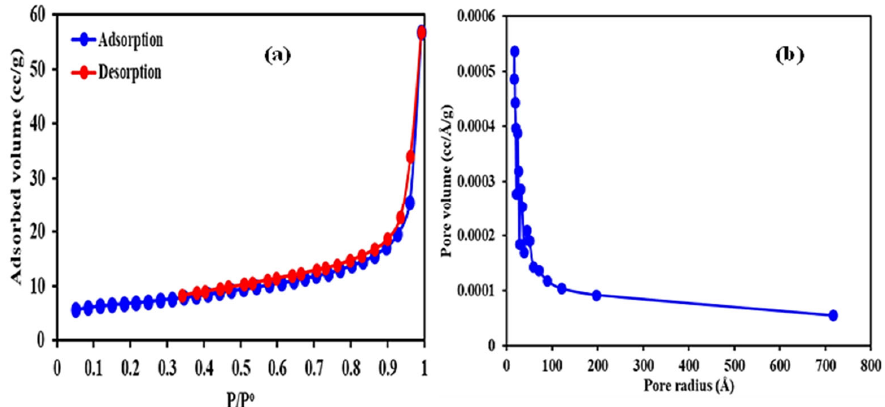
Figure 2. ( a ) N 2 adsorption–desorption isotherm of MgO nanorods and ( b ) Pore size distribution.